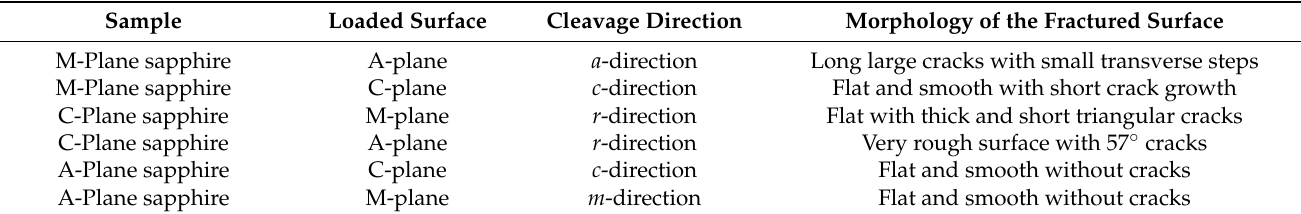
Table 5. Summary of the fracture characteristics of the specimens.